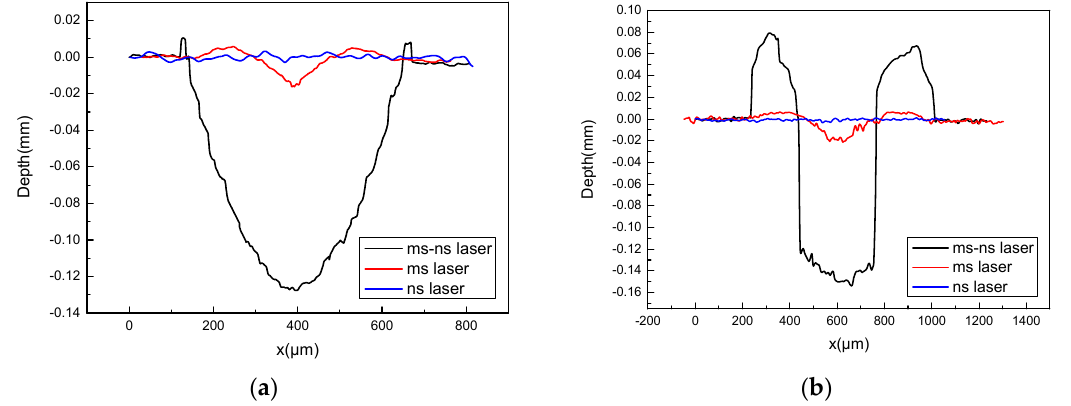
Figure 4. The profile of ablation morphologies under different spot size combination modes ( a ) the ns spot is larger ( b ) the ms spot is larger.